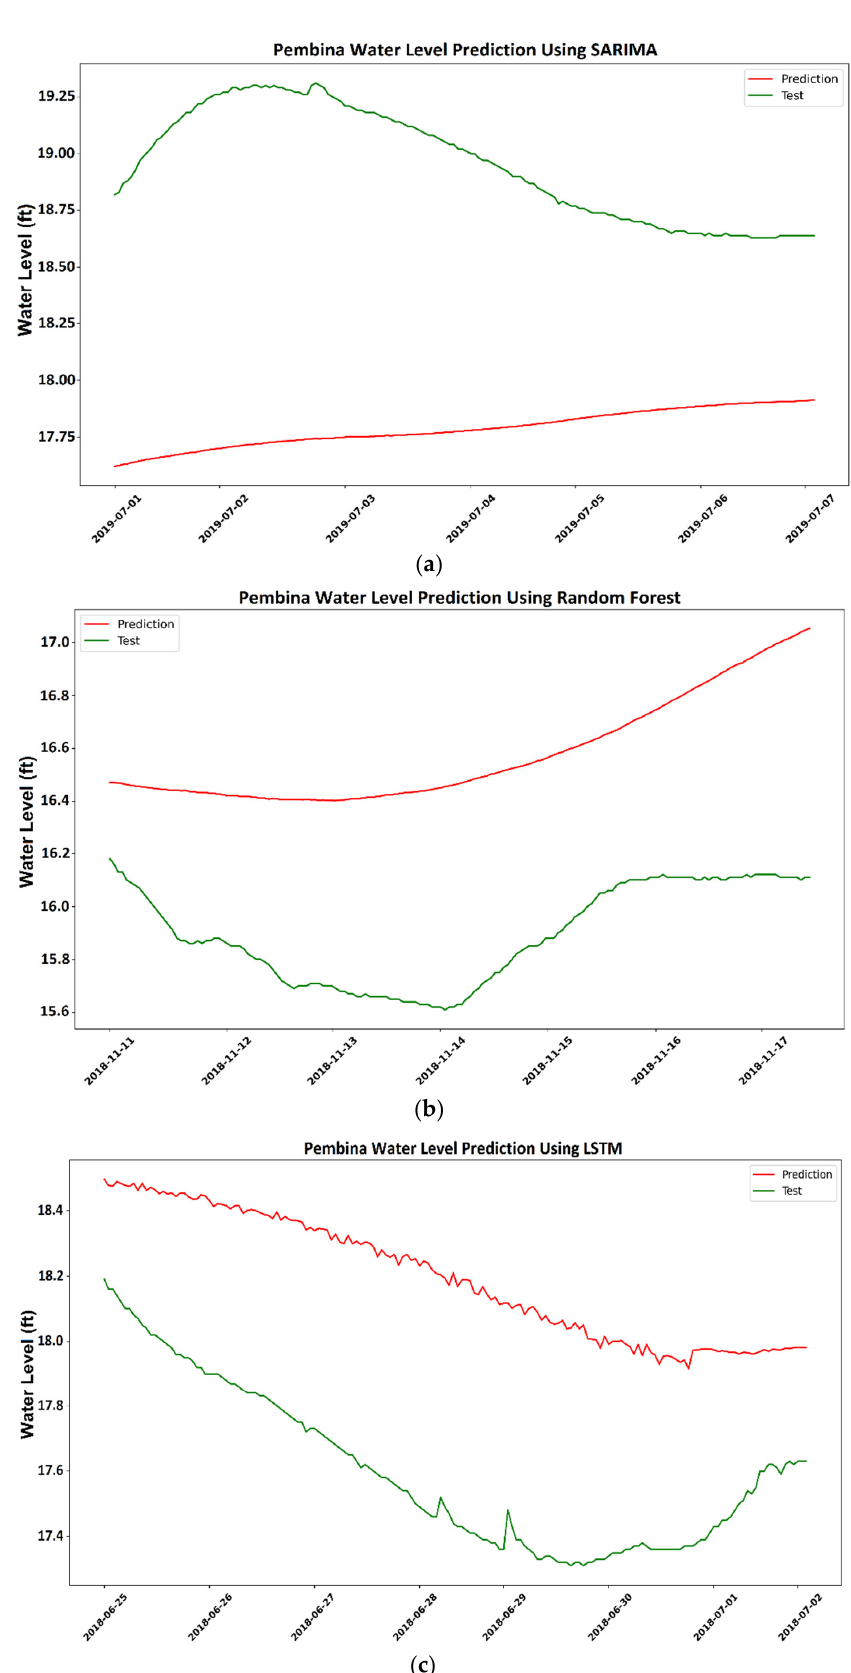
Figure 5. Visual comparison of one-week-ahead predicted values using ( a ) SARIMA, ( b ) RF, and ( c ) LSTM forecasting methods with true values on the Pembina series.